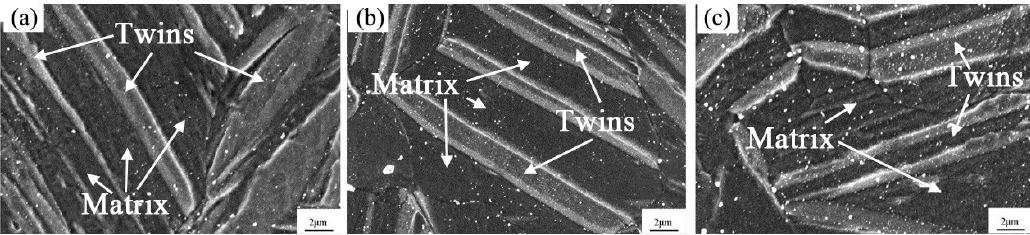
Figure 4. SEM micrographs of the distribution of precipitates in the pre-twinned ZK60 samples aged at 180 °C for ( a ) 3 h; ( b ) 10 h; and, ( c ) 50 h [33].